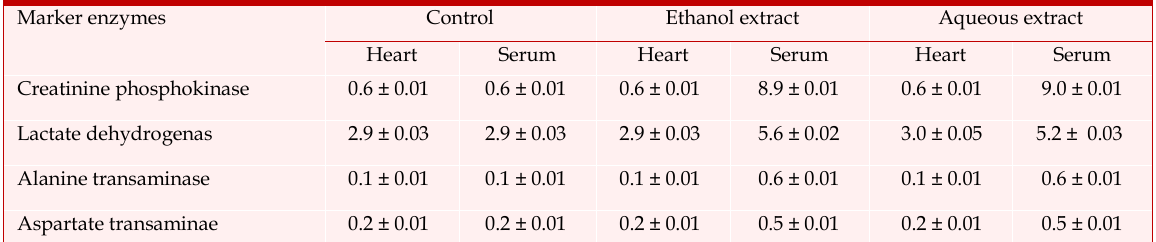
Effect of the extracts of Premna serratifolia n the clinical marker enzymes in rats Marker